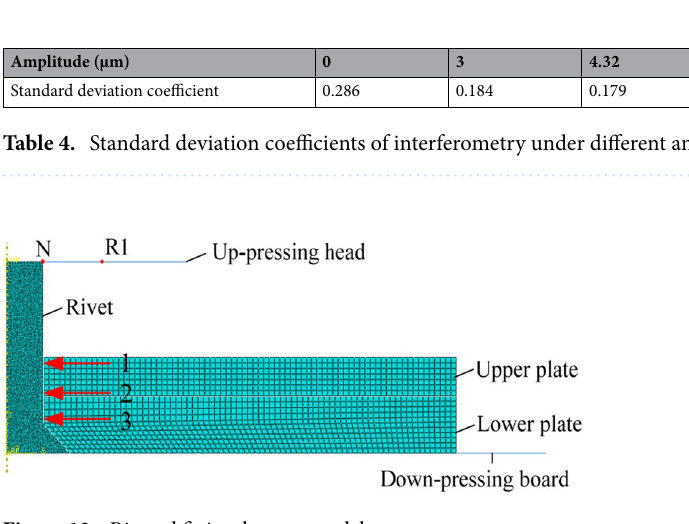
Figure 13. Riveted finite element